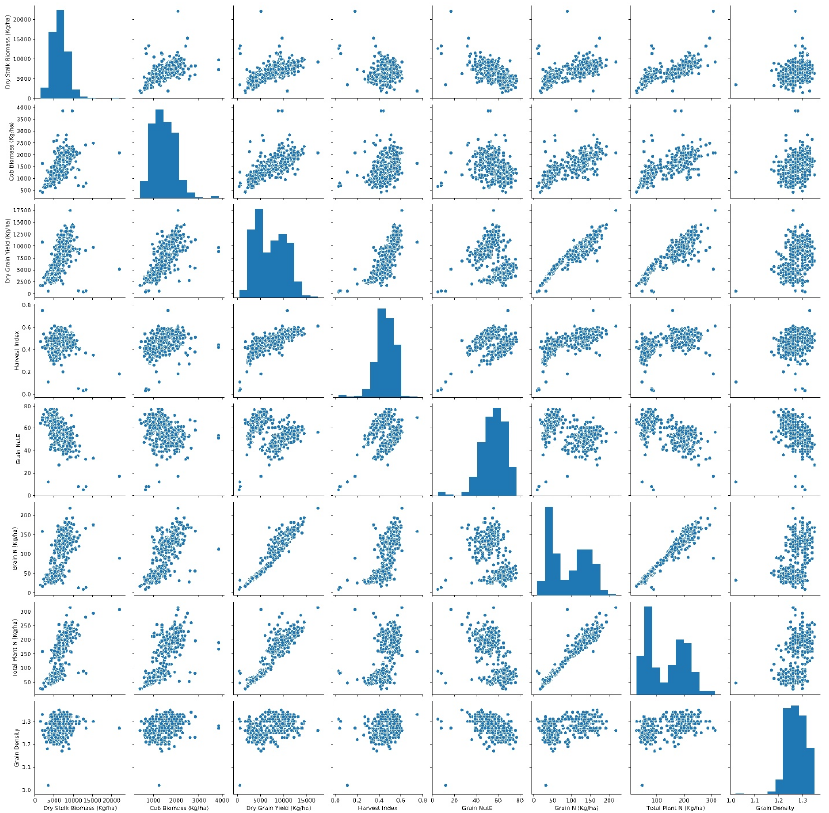
Figure A1. Histograms of Maize Phenotypes (In Diagonal) and Scatter Plots between Pairs of the Phenotypes.